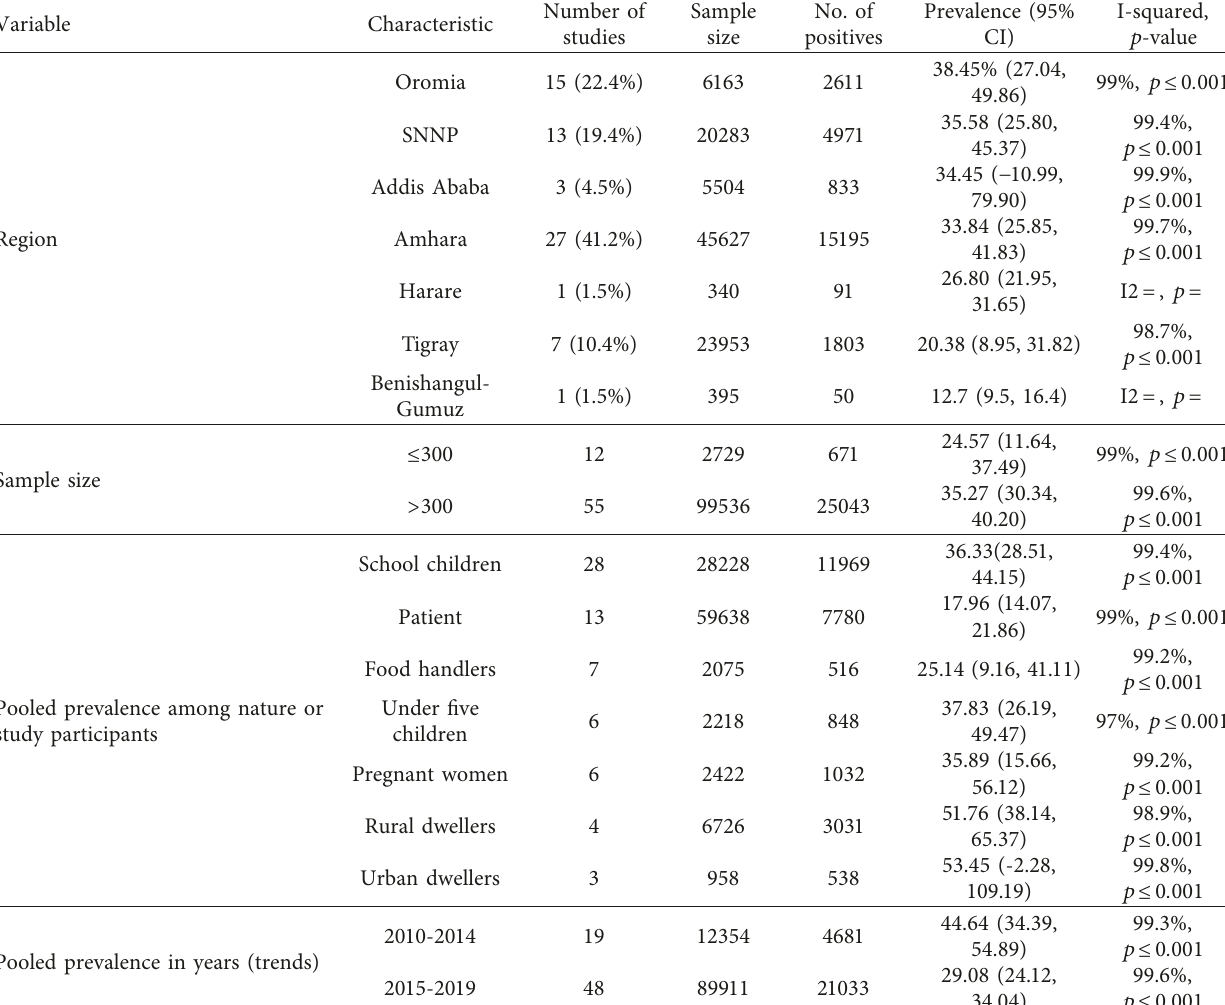
Table 2: Pooled prevalence of intestinal parasite among People in Ethiopia, 2020 ( n � 67).